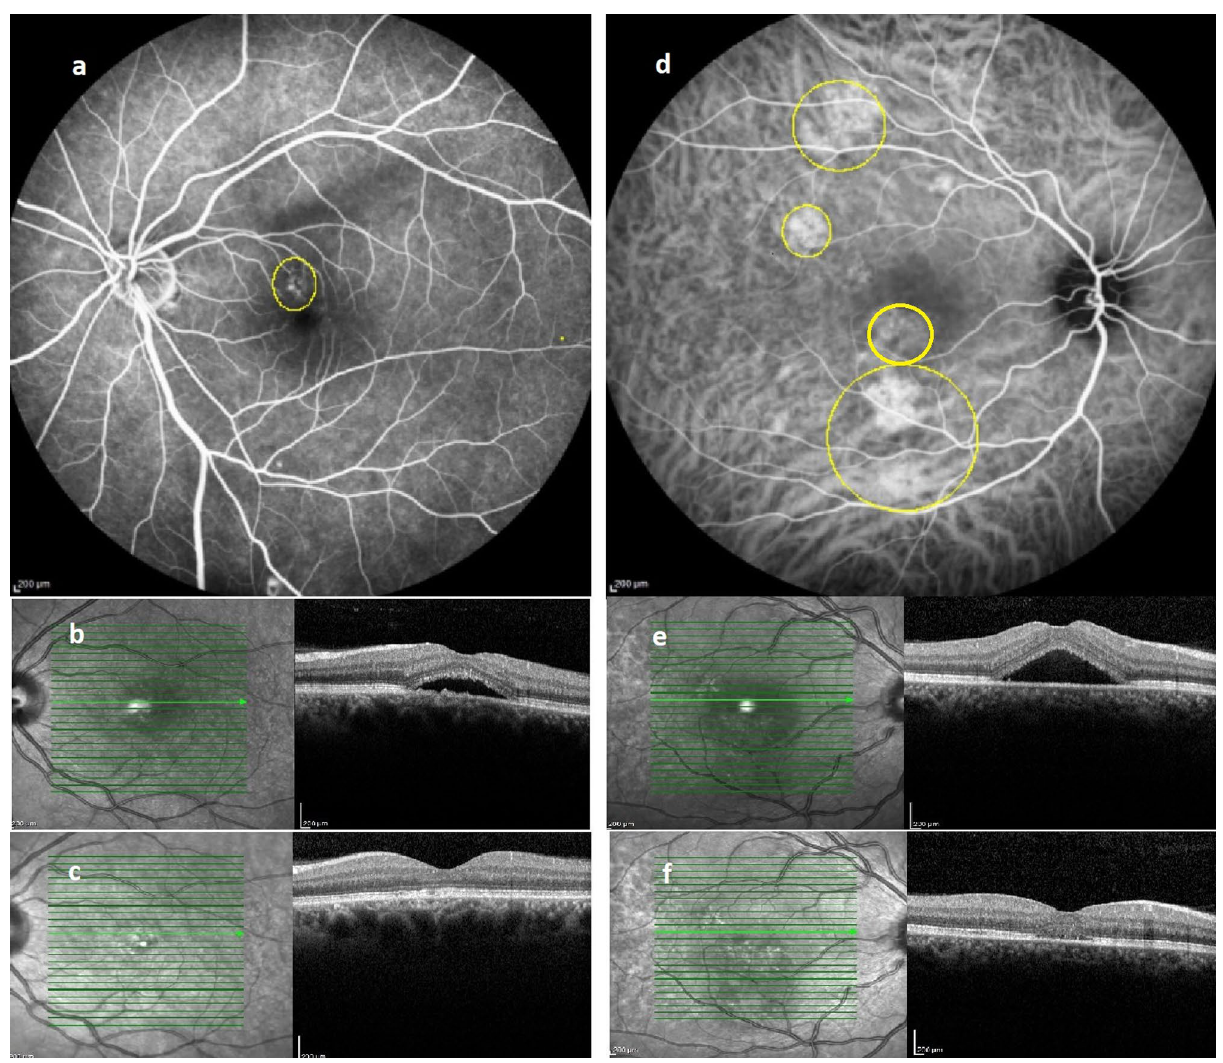
Figure 2. Representative image of patients in FA-based (left column) and ICGA-based (right column) PDT groups: FA; depicted area of leakage was treated with half dose PDT ( a ). Baseline OCT reveals foveal subretinal fluid ( b ), which completely resolved following treatment ( c ). ICGA; delineated areas corresponding to choroidal vascular hyperpermeability received half dose PDT ( d ). Baseline OCT reveals foveal subretinal fluid ( e ), which completely resolved following treatment ( f